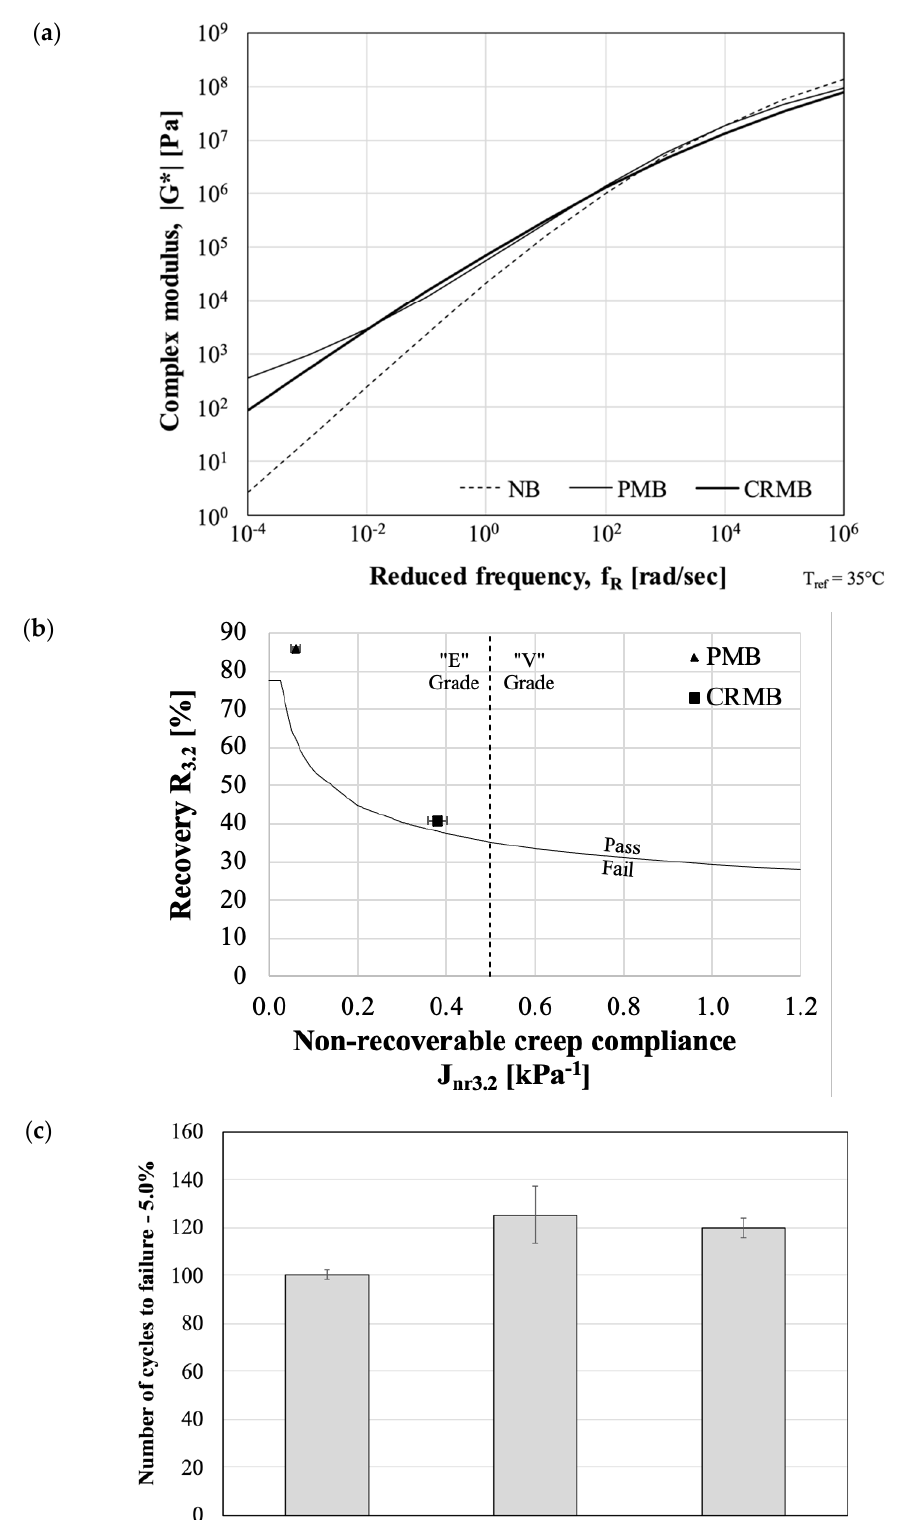
Figure 2. Results of Asphalt Binders: ( a ) Master Curves; ( b ) MSCR; ( c ) LAS. Binders were also subjected to multiple stress-creep recovery (MSCR) tests at 64 ◦ C The physical characteristics of the aggregates used in the mix-design process are re- and linear amplitude sweep (LAS) at 20 ◦ C. Following the procedure of the AASHTO ported in Table 1, while the design gradation of the DG and GG blends is shown in Figure M332 specification, MSCR tests were carried out by imposing two stress levels (0.1 kPa 3. Table 1. Physical characteristics of aggregates.